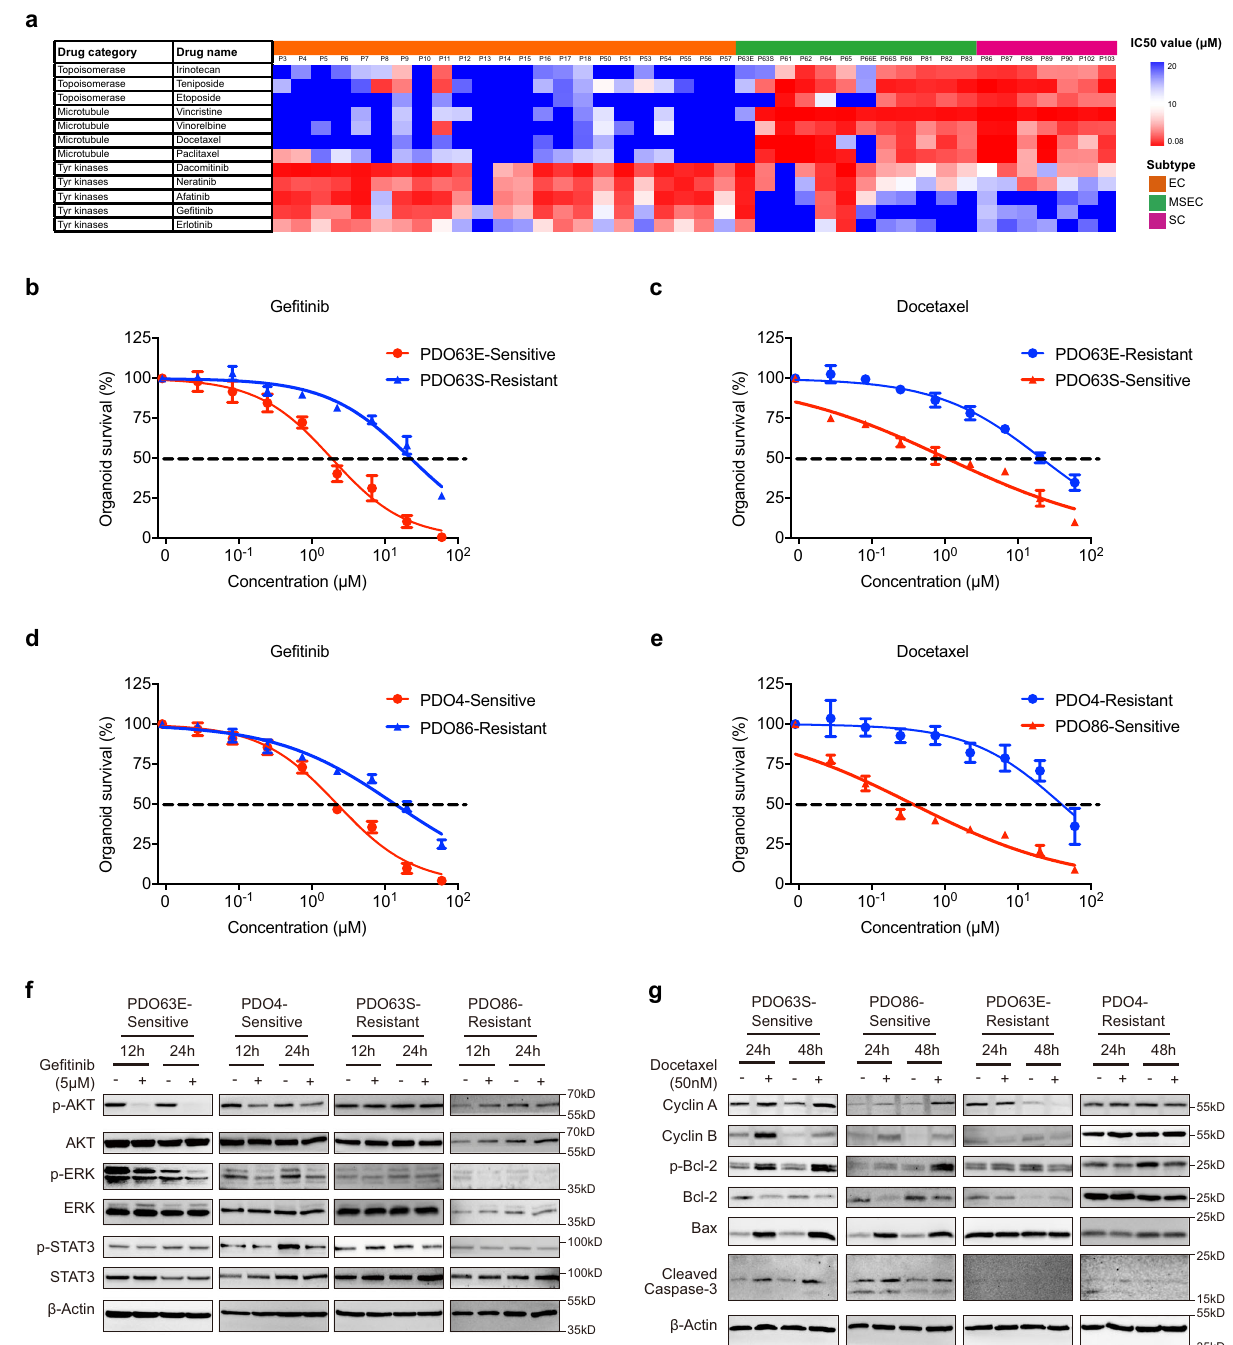
Fig. 4 Drug treatment on patient-derived organoids (PDOs). a Heatmap showing subtype-speci fi c drug responses (IC50 values) of topoisomerase (irinotecan, teniposide and etoposide), microtubule (vincristine, vinorelbine, docetaxel and paclitaxel) and EGFR (dacomitinib, neratinib, afatinib, ge fi tinib, and erlotinib) inhibitors on 42 NPC PDOs. b Representative ge fi tinib response curves on sensitive MSEC-derived organoids PDO63E and resistant MSEC- derived organoids PDO63S. c Representative docetaxel response curves on sensitive MSEC-derived organoids PDO63S and resistant MSEC-derived organoids PDO63E. d Representative ge fi tinib response curves on sensitive EC-derived organoids PDO4 and resistant SC-derived organoids PDO86. e Representative docetaxel response curves on sensitive SC-derived organoids PDO86 and resistant EC-derived organoids PDO4. Sensitive drug response curves ( b – e ) are presented with red color, and resistant curves ( b – e ) are labelled with blue color. Data points ( b – e ) represent mean % viability relative to control ± SEM, for n = 3 biological replicates. Graphs ( b – e ) are representatives of 3 independent experiments. f , g Western blot analysis on EGFR downstream proteins ( f ) of ge fi tinib sensitive organoids PDO63E and PDO4, and resistant organoids PDO63S and PDO86; Mitotic checkpoint and apoptotic proteins ( g ) of docetaxel-sensitive organoids PDO63S and PDO86, and resistant organoids PDO63E and PDO4. Blots are representatives of two independent repeats. Western blot analysis demonstrated by more PDO samples are shown in supplementary Fig. 9a,b.